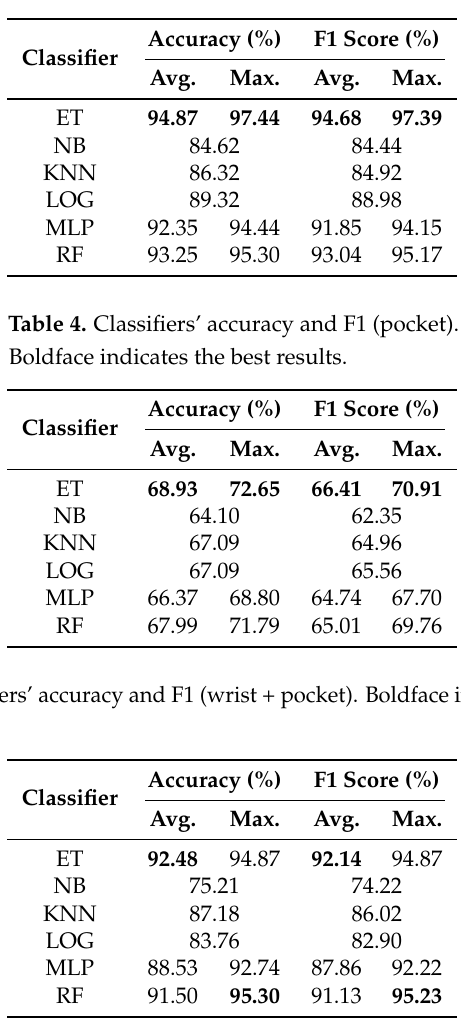
Table 3. Classifiers’ accuracy and F1 (wrist). Boldface indicates the best results.